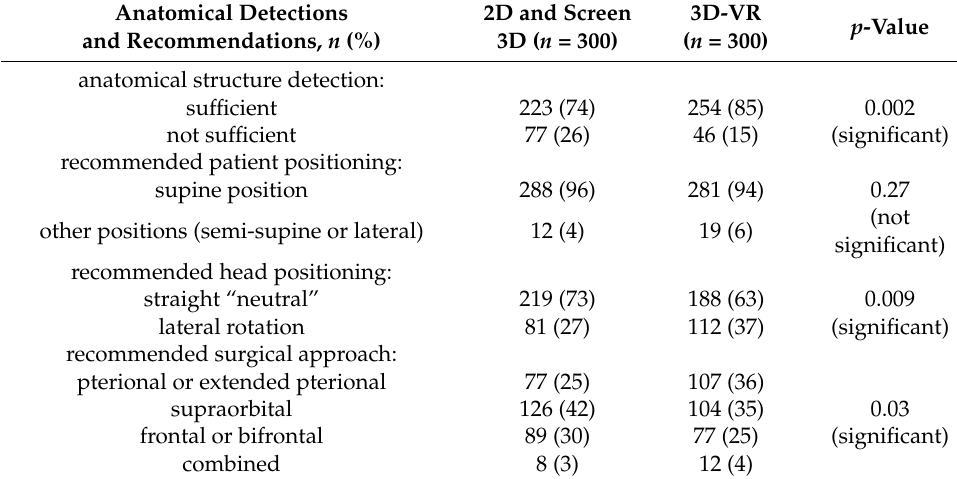
Table 3. Anatomical structure detection and recommended surgical strategy * after presenting conventional CT and MRI scans (2D and screen 3D) or reconstructed 3D-VR images, evaluated using Fisher’s exact test, assuming a p -value <0.05 to be